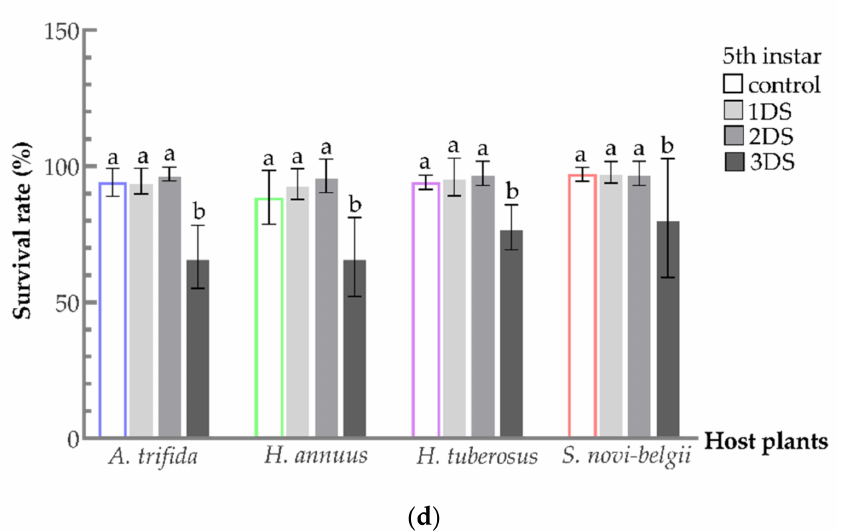
Figure 3. Survival rate of C. marmorata nymph suffering from food deprivation on four host plants: ( a ) 2nd instar nymph; ( b ) 3rd instar nymph; ( c ) 4th instar nymph; and ( d ) 5th instar nymph.